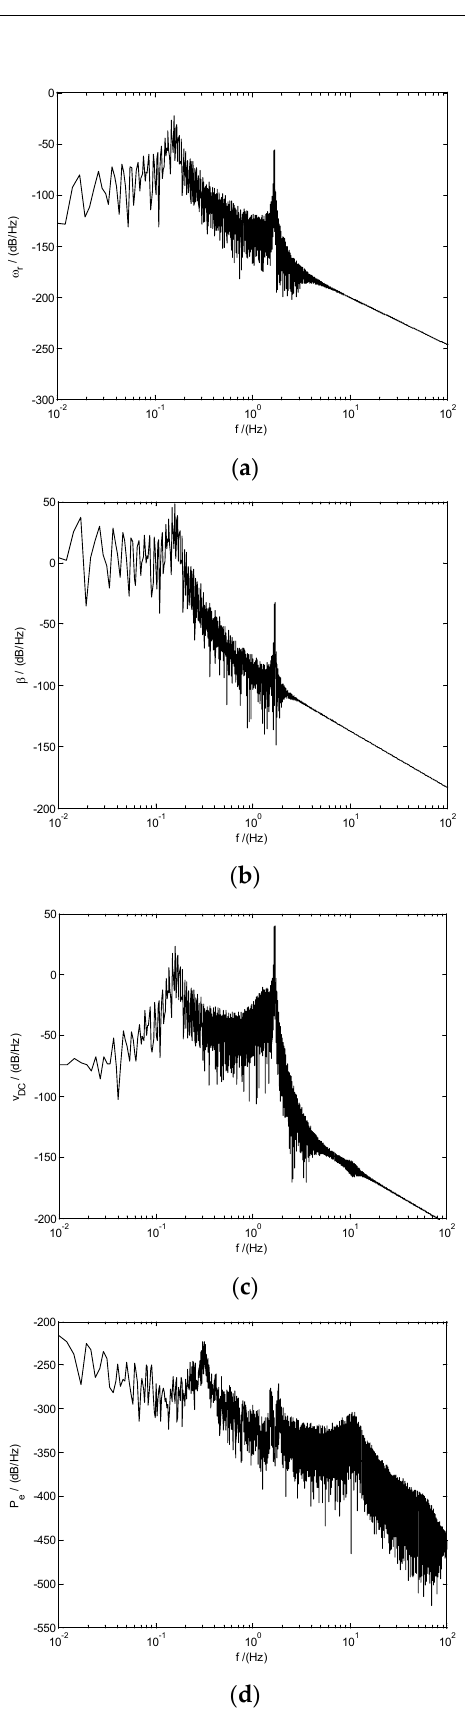
Figure 4. PSD of the simulated output signals. ( a ) Generator angle speed ω r ; ( b ) pitch angle β ; ( c ) DC capacitor voltage v DC ; ( d ) active power P e